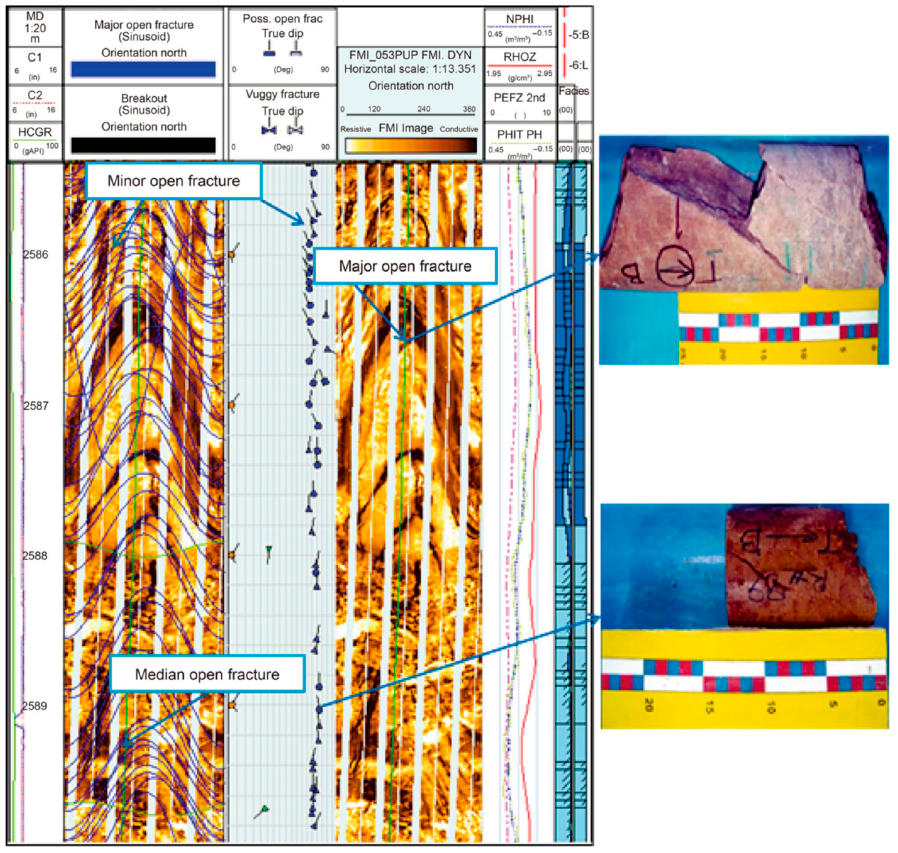
Figure 2. FMI image and core of a carbonate formation: major open fractures blue square dips, medium open fractures (blue circular dips), and minor open fractures (blue triangle dips) [11].